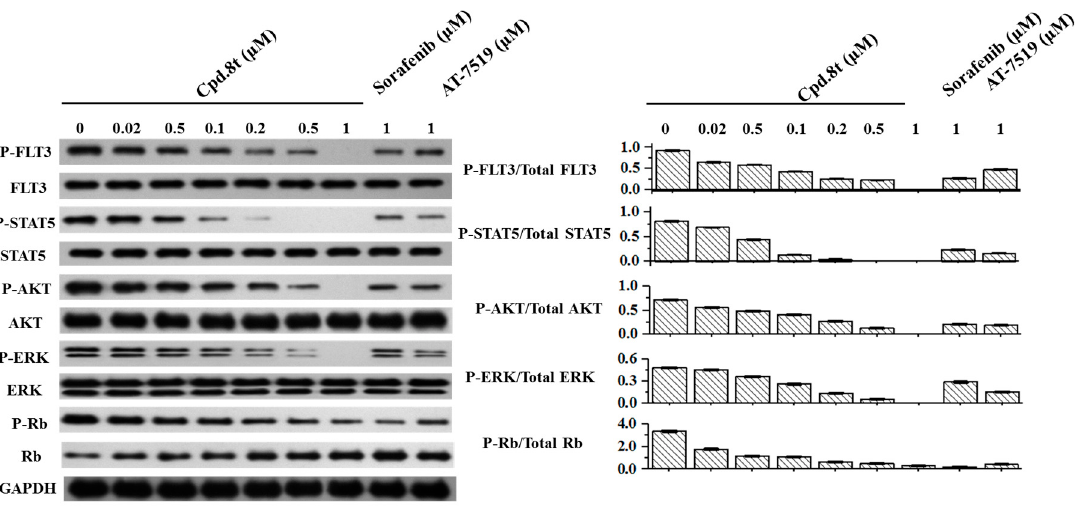
Figure 5. MV4-11 cells were treated with compound 8t , AT-7519, or sorafenib for 4 h, and the phosphorylation of FLT3, STAT5, ERK, AKT, and Rb protein was analyzed by